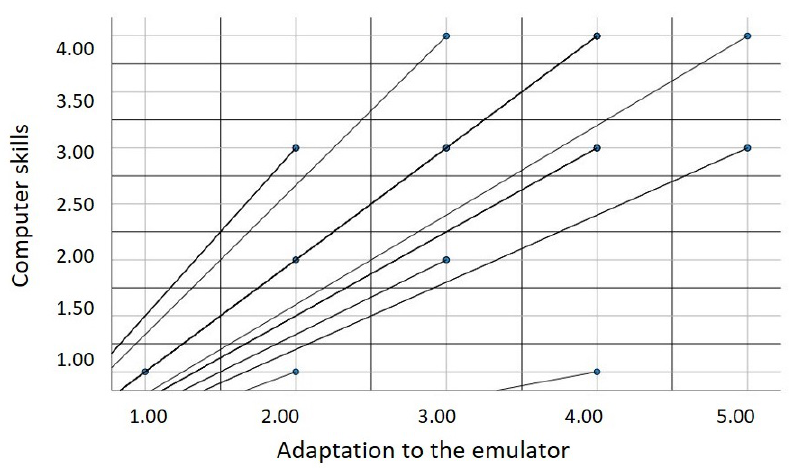
Figure 12. Relationship between prior computer skills and adaptability to the emulator.